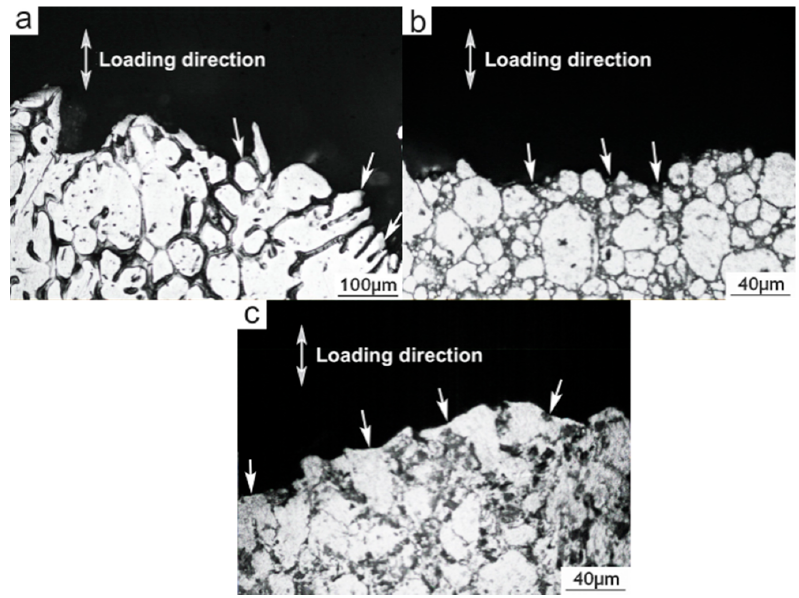
Figure 7. Side views of fracture surfaces of: ( a ) PMC-6061 alloy; ( b ) PTF-6061 alloy; ( c ) PTF-SiCp/6061 Al composite.